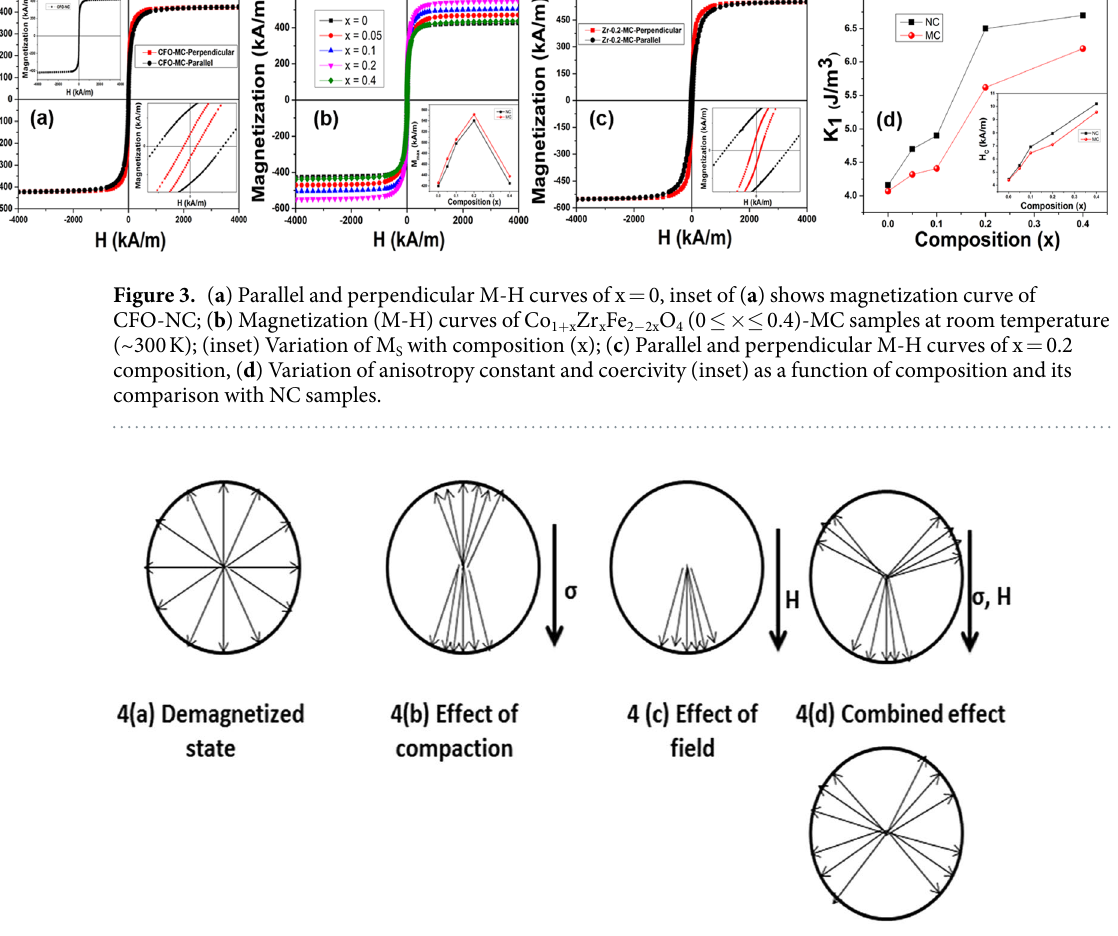
For cobalt ferrite the first order anisotropy constant K 1 is about 4 × 10 5 J/m 3 . The energy of the applied stress (left side quantity in Eq. 3) in the present investigation is greater than the crystal anisotropy; hence it orients the domain in the direction of compaction as shown in Fig. 4(b) due to the two-fold symmetry of the stress field energy (Eq. 1). Applied magnetic field during compaction tries to orient the domains in the field direction as shown in 4(c) due to the one-fold symmetry of the Zeeman energy generated by the magnetic field (Eq. 2). The